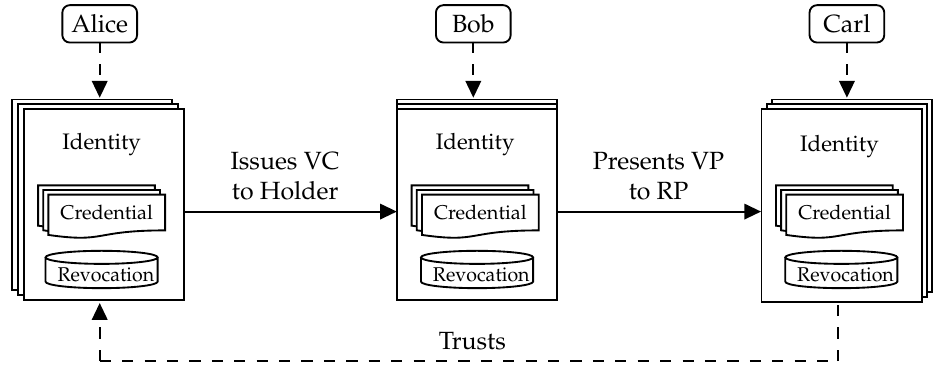
Figure 2. The actors, their electronic identities, and the interactions to issue a VC and present a